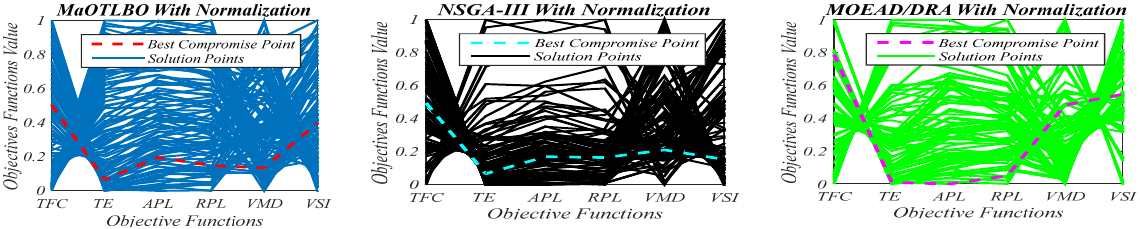
Fig. 8. Obtained Pareto front with normalization on MaO-OPF 6-objective problem using MaOTLBO, NSGA-III, and MOEA/D-DRA algorithms The control variables and objective functions of CS solutions for the IEEE-30 bus test system